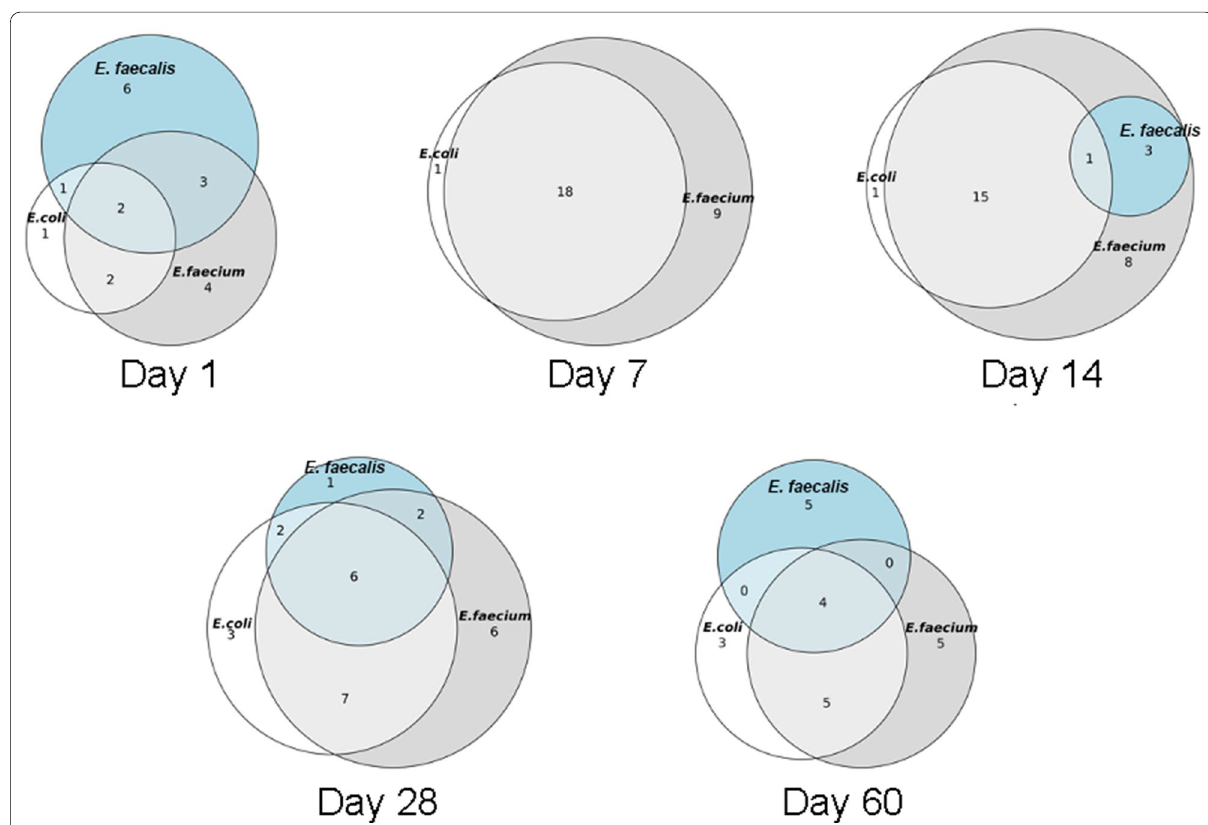
Fig. 5 Venn diagrams displaying distribution of dogs in which a MDR pathogen was recovered from fecal samples at the different time points. For example, on day 1, one dog had 1 MDR E.coli only isolated, 6 dogs had MDR E. faecalis only isolated, 4 dogs had MDR E. faecium only, one dog had MDR E.coli and E. faecalis recovered, 2 had MDR E.coli and E. faecium , 3 had MDR E. faecalis and E. faecium recovered, and 2 dogs had all 3